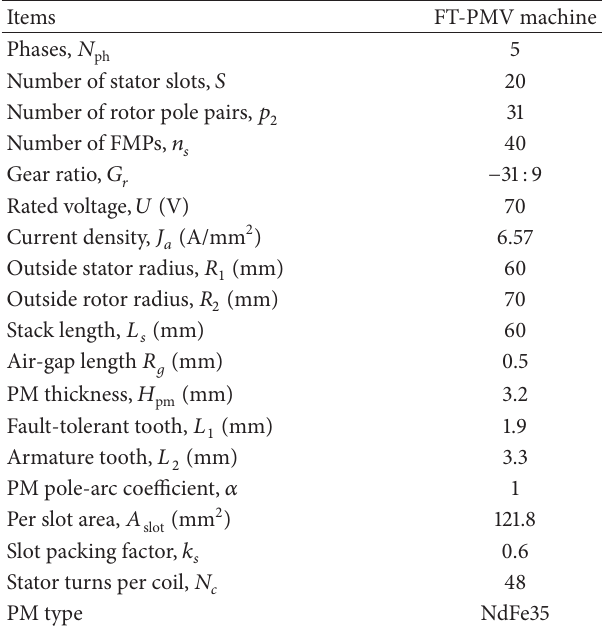
Table 3: Machine design